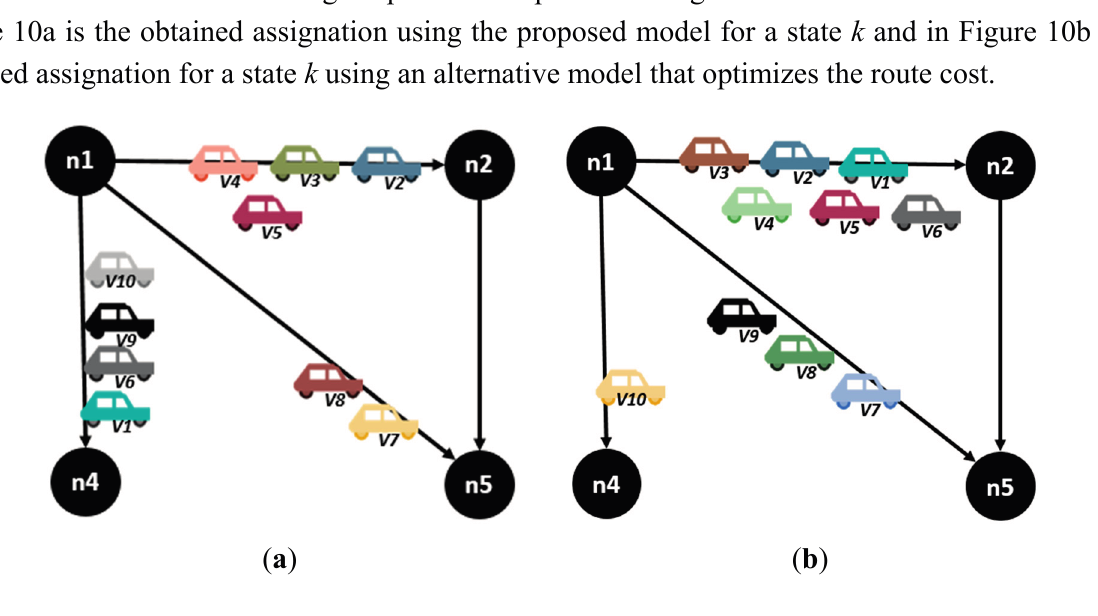
Figure 10. Obtained assignation using ( a ) the proposed model and ( b ) other optimization model based on route cost. ( a ) Obtained assignation with the proposed model ( b ) Obtained assignation with other